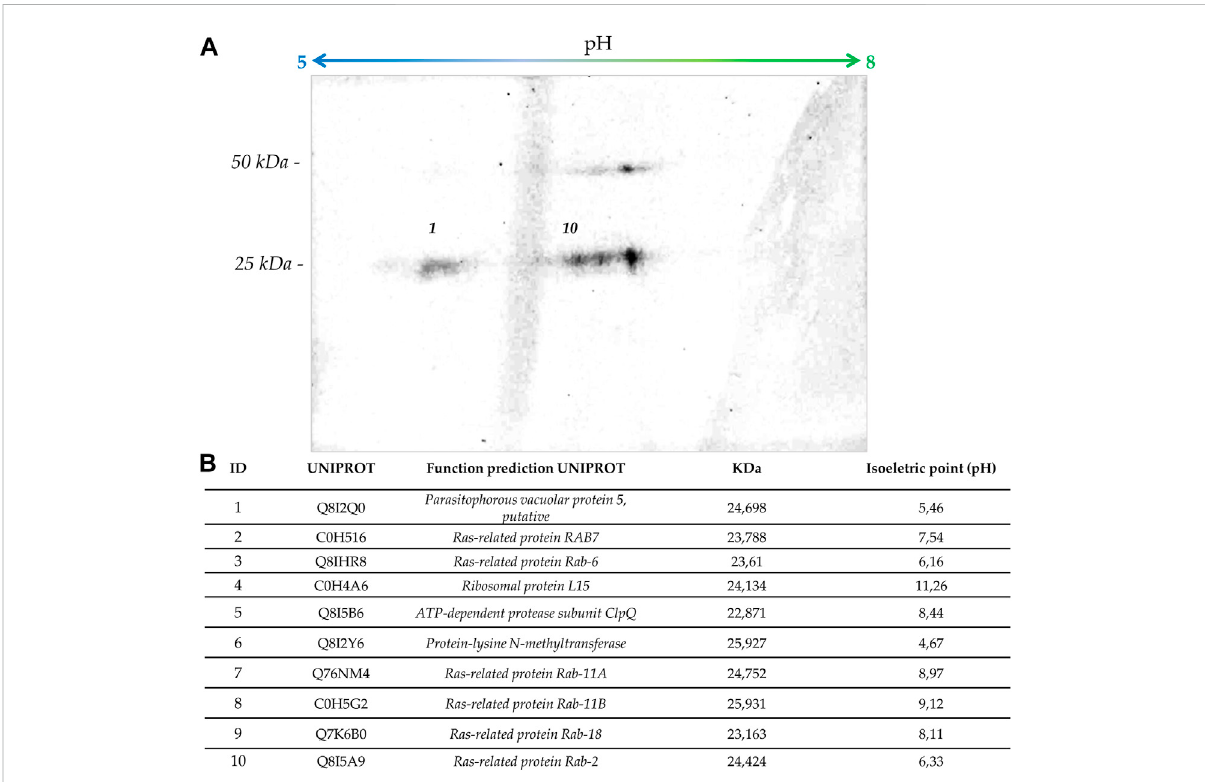
FIGURE 5 Proteomicanalysis. (A) The fi gureshowsanauto-radiographyof2Dgelswith[ 3 H]FOH-labelledproteinsof P.falciparum . (B) Thetableindicates those ~25 kDa prenylated proteins identi fi ed by mass spectrometry together with their molecular weight and isoelectric point